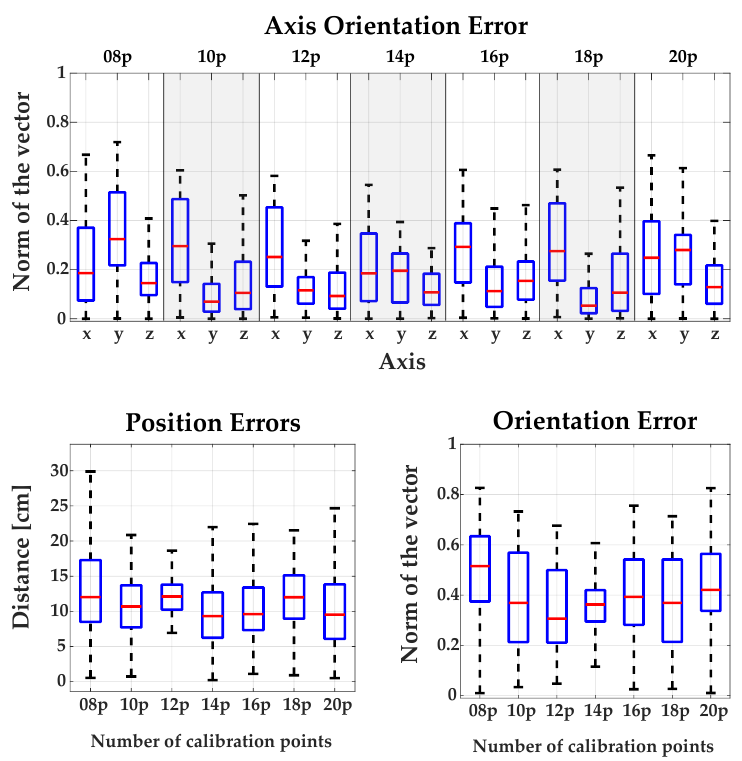
Figure A1. Results obtained by the direct calibration method using different numbers of calibration